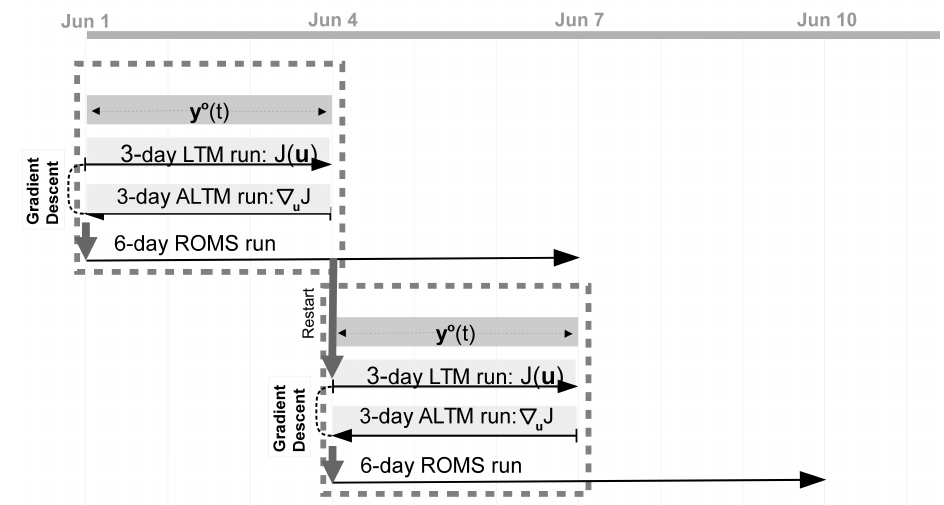
Figure 14. Data assimilation cycle in Yu et al. (2012). The data assimilation is done with the help of a linear tangent model (LTM) and its adjoint code (ALTM). The LTM is an approximation to the linearized dynamics of the ROMS model, used for both the forecast step and to define the reference solution of the LTM model. No overlap between the different assimilation